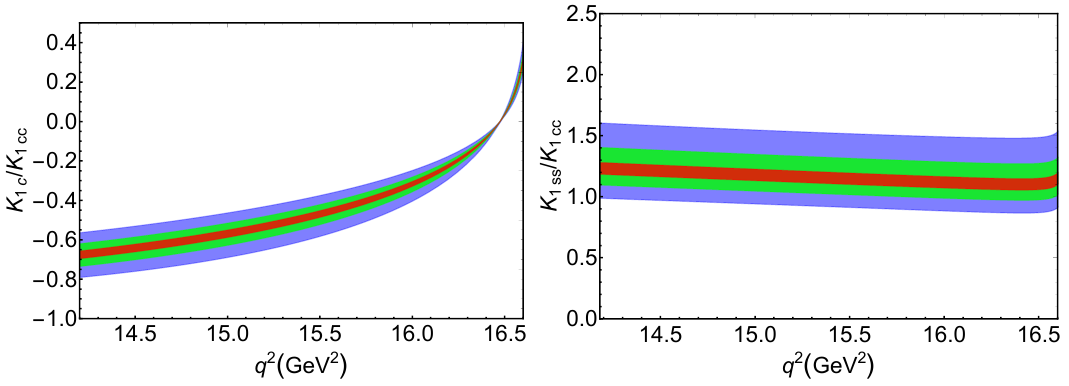
Figure 2 . The SM predictions of K 1 c =K 1 cc and K 1 ss =K 1 cc at low-recoil for (cid:3) b ! (cid:3) (cid:3) ( ! N (cid:22) K ) (cid:22) + (cid:22) (cid:0) . The meaning of the bands are same as in the (cid:12)gure 1. The (cid:12)gures are for illustrative purpose only (see text for details).